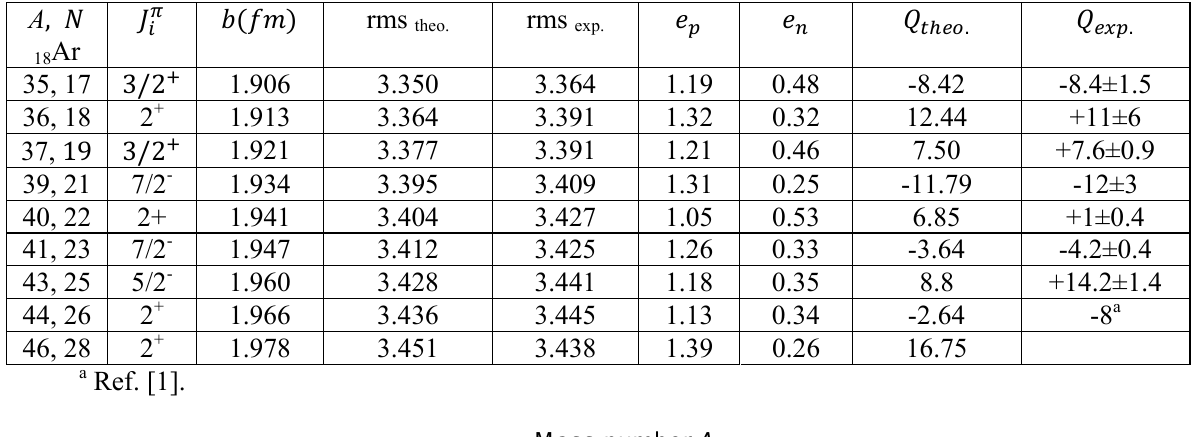
Table 6: Quadrupole moments in units of (cid:2187) (cid:2188)(cid:2195) (cid:2779) calculated with harmonic oscillator (HO) for Argon (Ar) isotopes (Z = 18). Effective proton and neutron charges are deduced from the core polarization calculation. Experimental quadrupole moments are taken from Ref. [18].